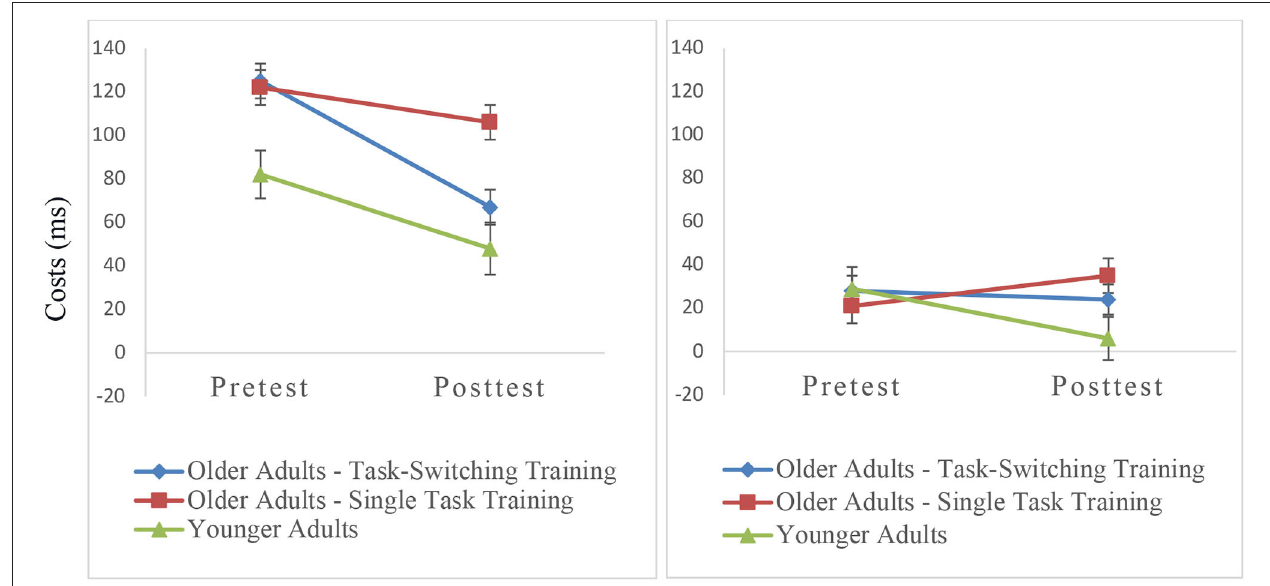
FIGURE 3 | Mixing costs (left) and switching costs (right) on the level of mean RT as a function of group and session. Error bars refer to standard errors of the